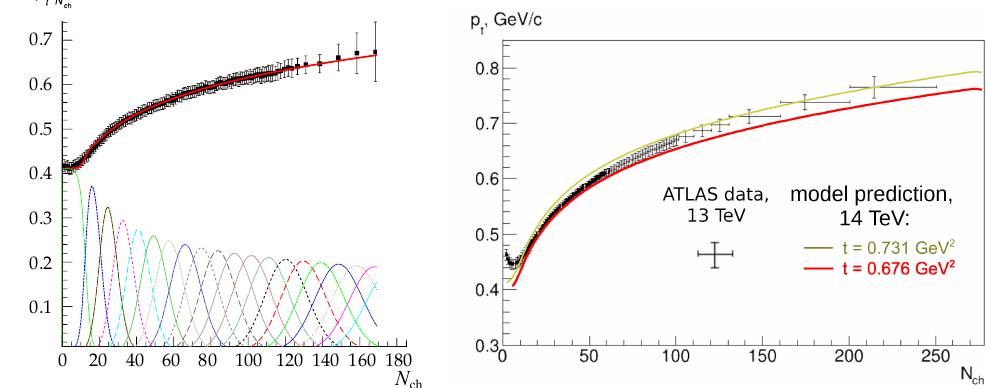
√ s = 7 TeV using (9). Pseudo-